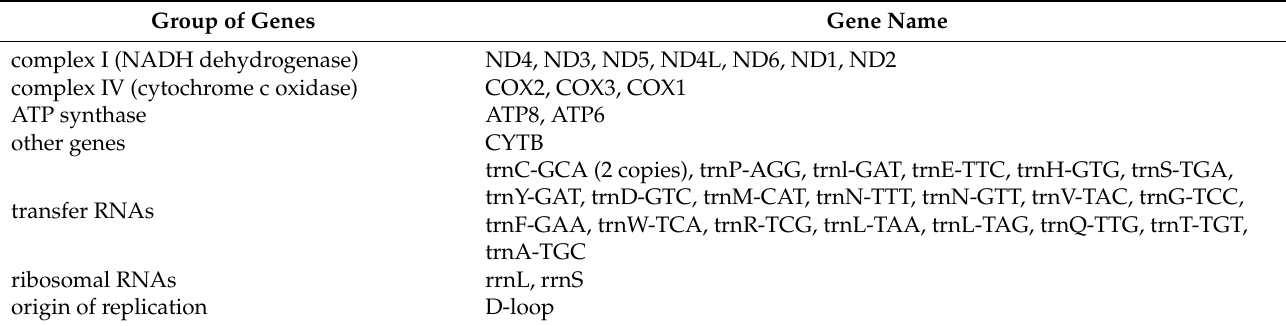
Table 5. Gene content of the Ruditapes variegatus genome.